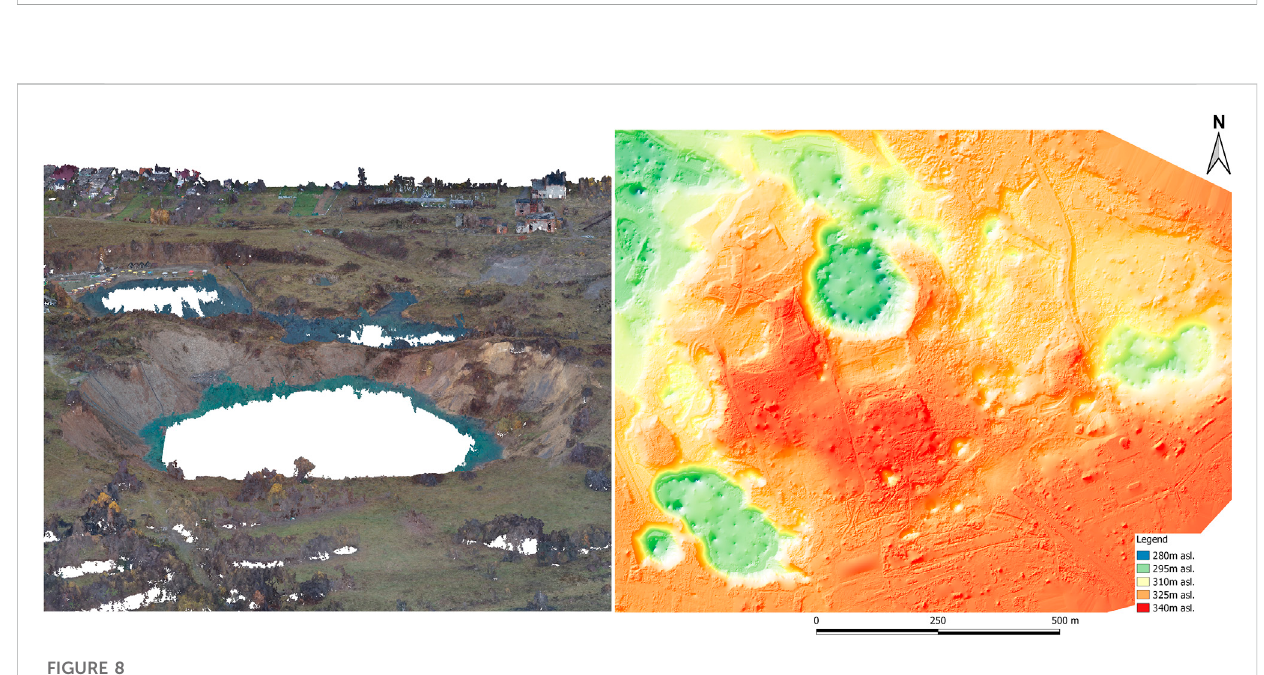
was within 4 cm. The point cloud was fi ltered and cleaned of noise and classi fi ed into common classes. In order to get properly classi fi ed ground data, vegetation fi ltering on a steep slope within sinkholes had to be done ( Š troner et al., 2021).